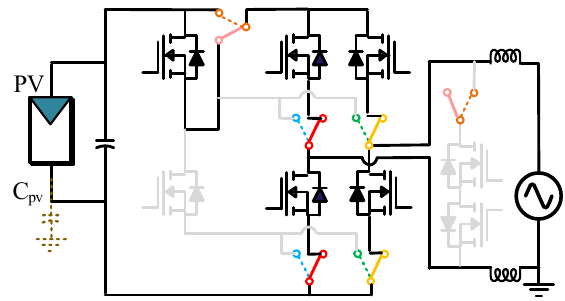
Figure 5. Configuration after a fault in S b .